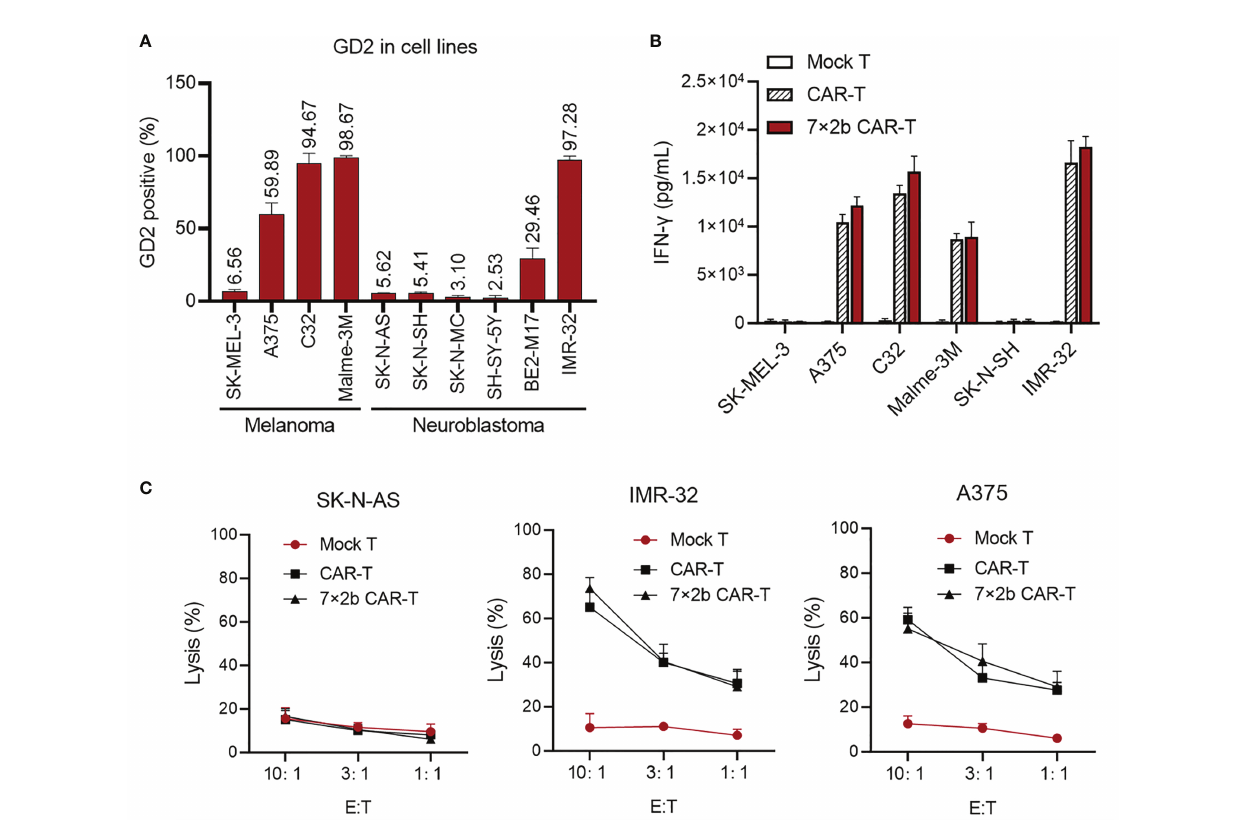
FIGURE 2 | The effect of 7×2b CAR-T cells on tumor cells. (A) The expression of GD2 in melanoma and neuroblastoma cell lines. (B) After co-incubation for 12 h at a ratio of 10:1, the supernatant was removed to detect the IFN- g secretion level by ELISA. (C) Luciferase-based reporter assays were used to detect the lysis (%) of 7×2b CAR-T cells against three melanoma and neuroblastoma cells with different E:T